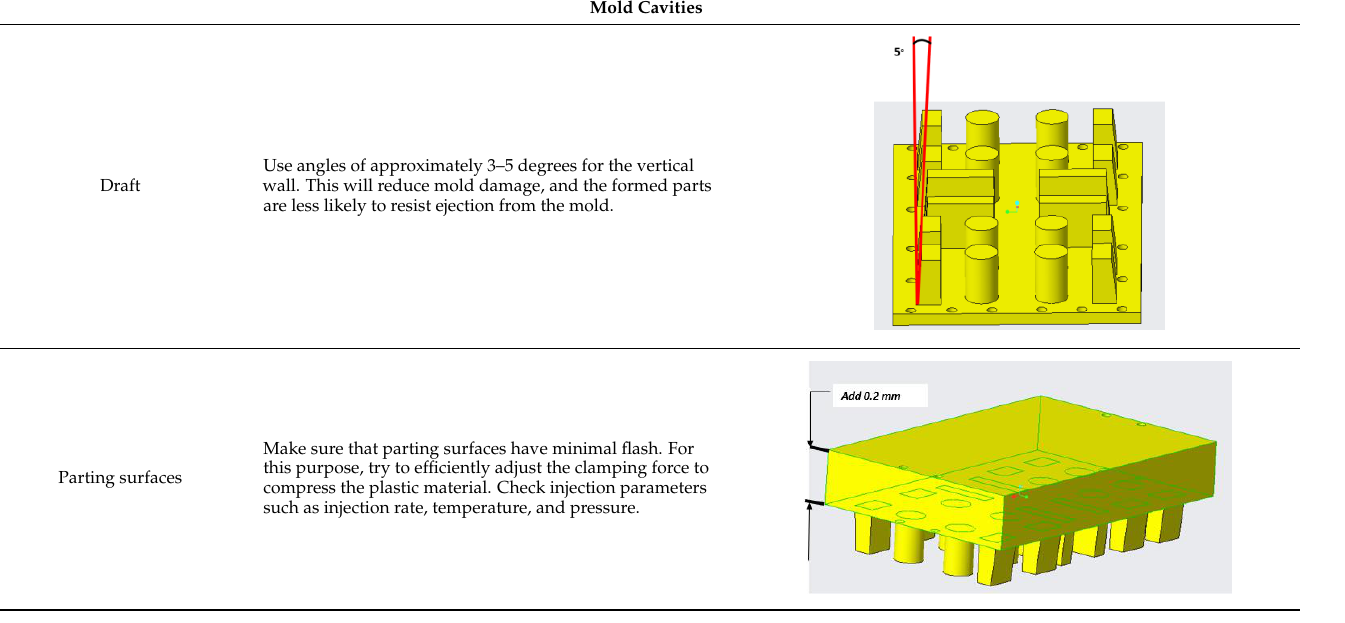
Table 2. Technical guide to design mold cavities based on recent studies in the field [40,43 – 46]. Mold Cavities